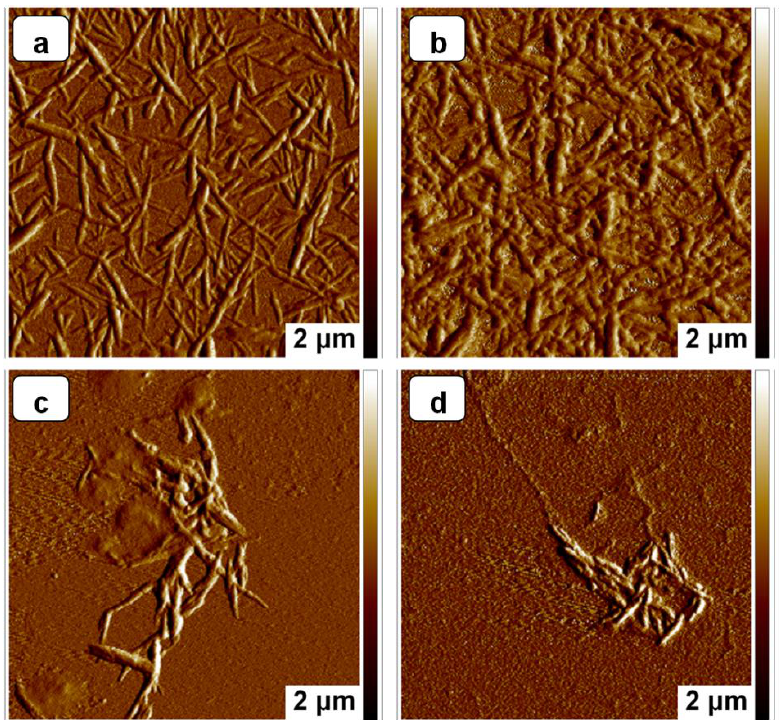
Figure 5. AFM images of NCC before ( a ) and after ( b ) freeze-drying, KH560-NCC ( c ) and C12-KH560-NCC ( d ).